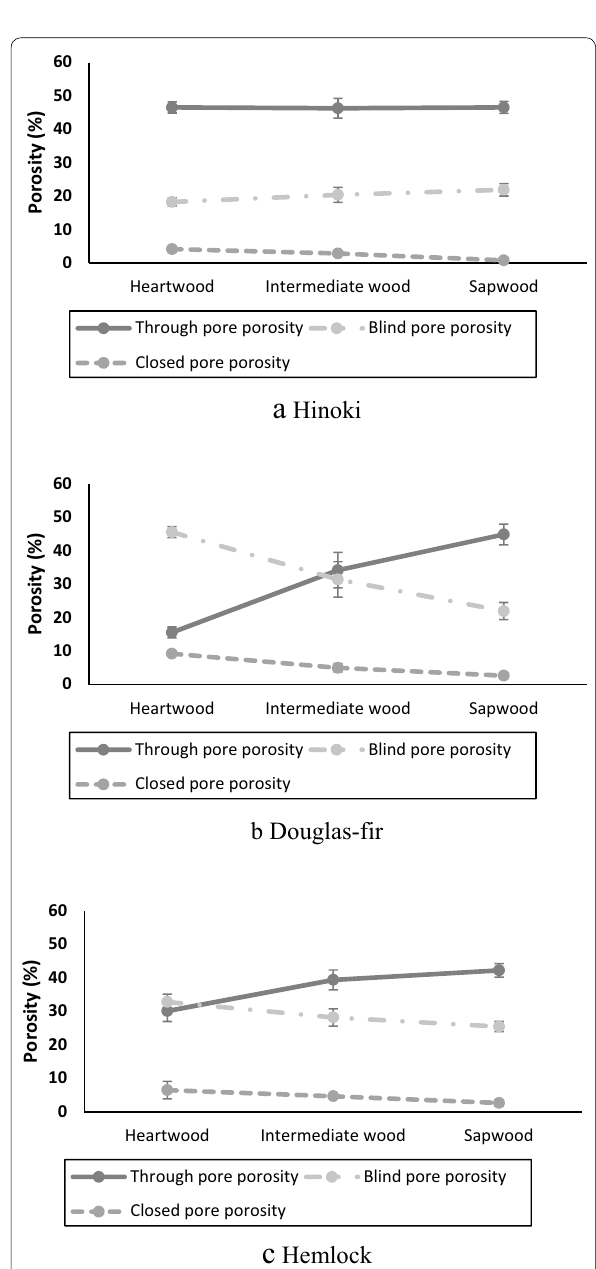
Fig. 7 Results of porosity analysis of heartwood, intermediate wood and sapwood in three species of softwood (error bar; standard